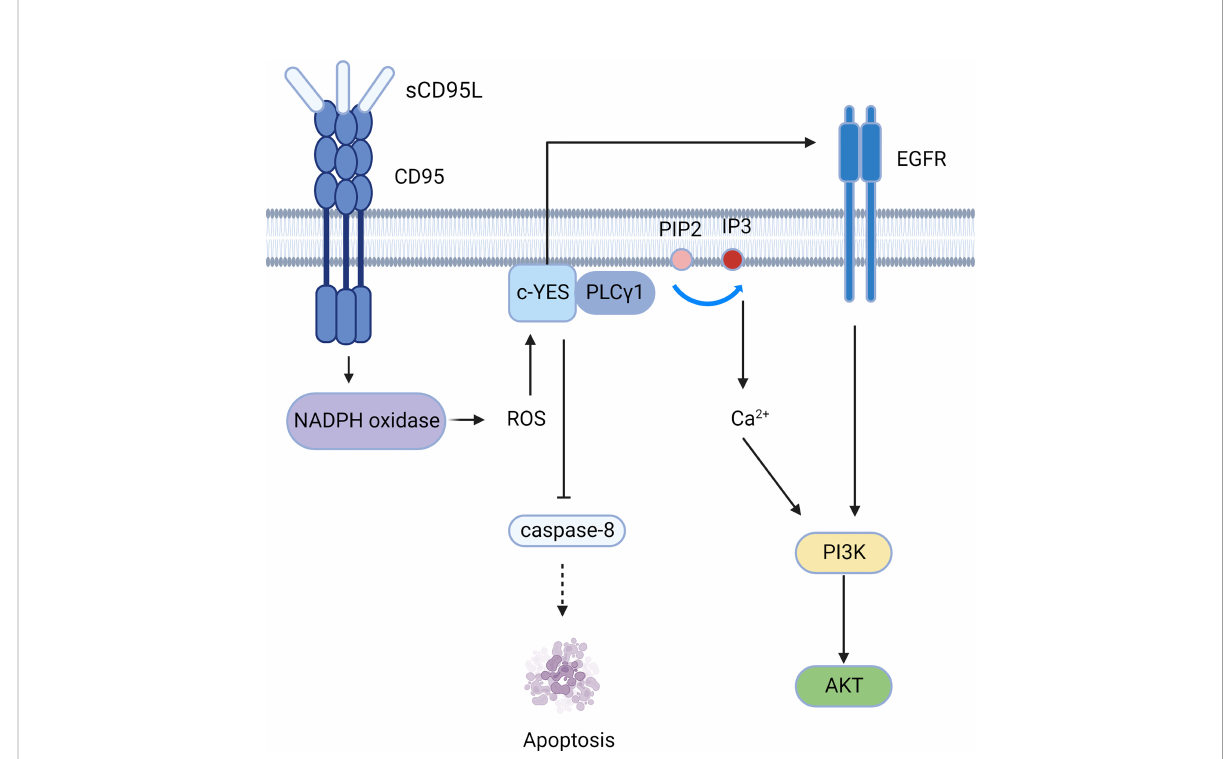
FIGURE 4 The PI3K-AKT signaling pathway mediated by CD95. CD95 induces the c-YES/calcium/PI3K pathway and c-YES/EGFR/PI3K pathway to mediate cell